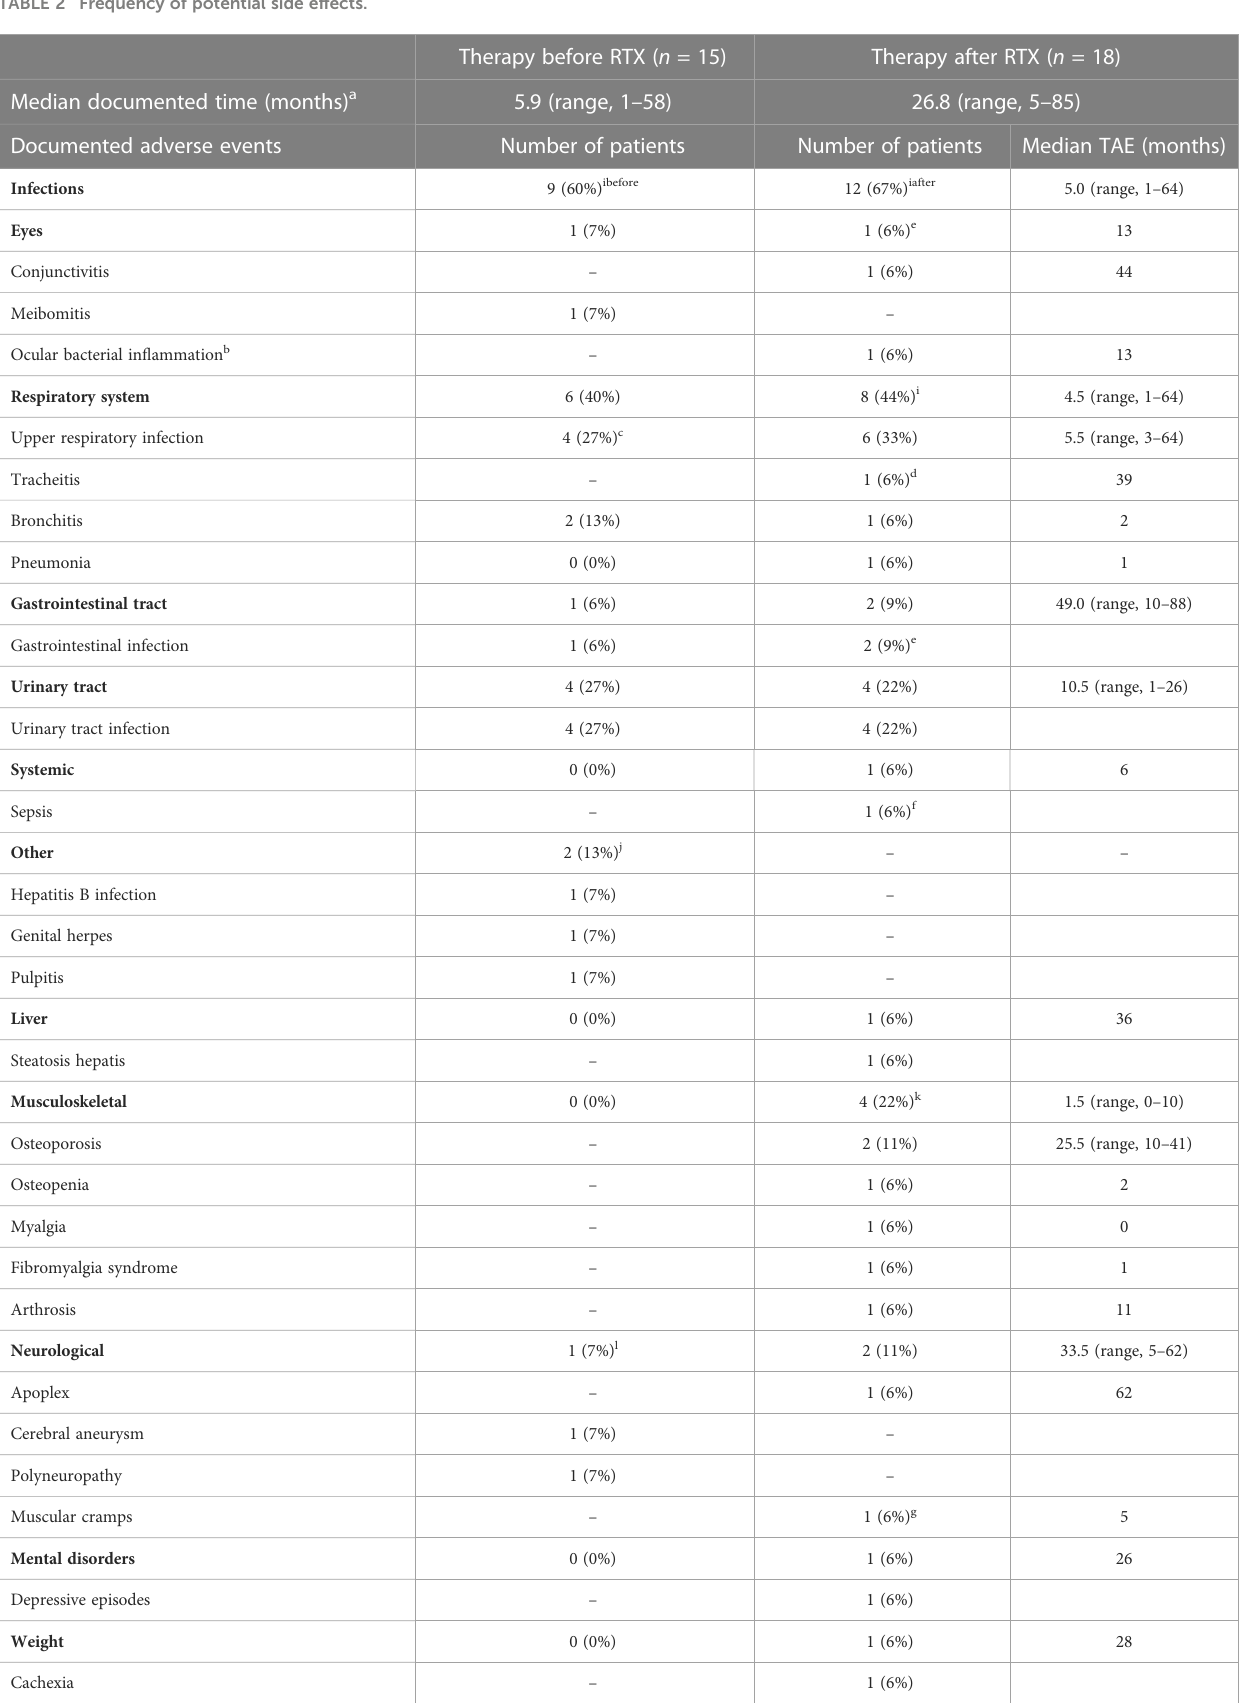
TABLE 2 Frequency of potential side